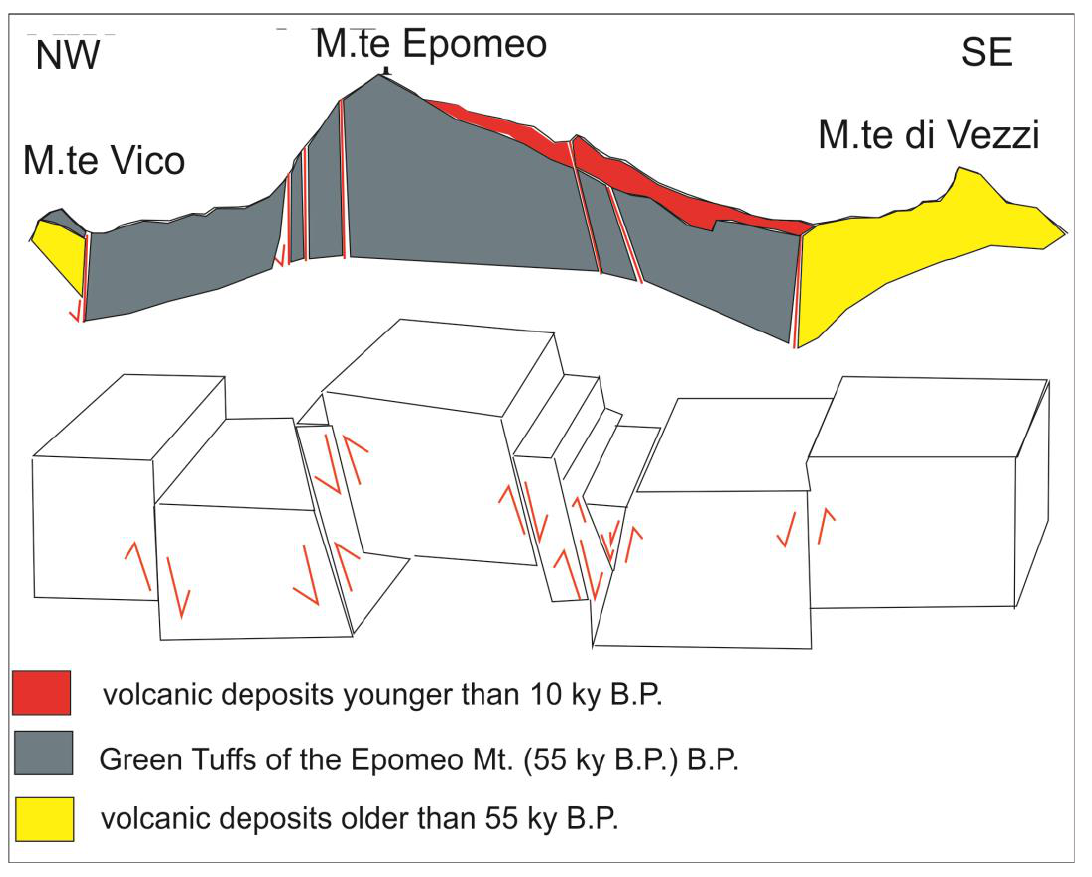
Figure 6. The model of block resurgence of Ischia proposed by Orsi et al. [11].